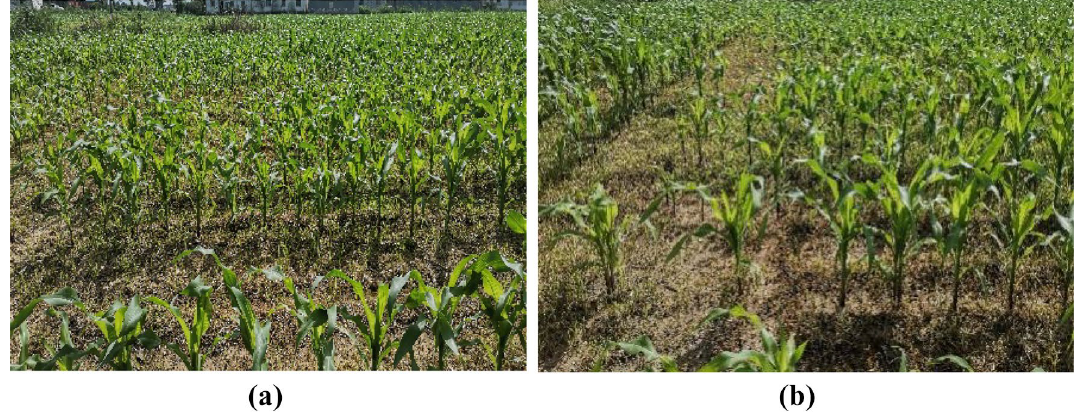
Figure 14. Field validation test and seeding effect under field conditions. ( a ) Inclined seed-metering device; ( b ) vertical seed-metering